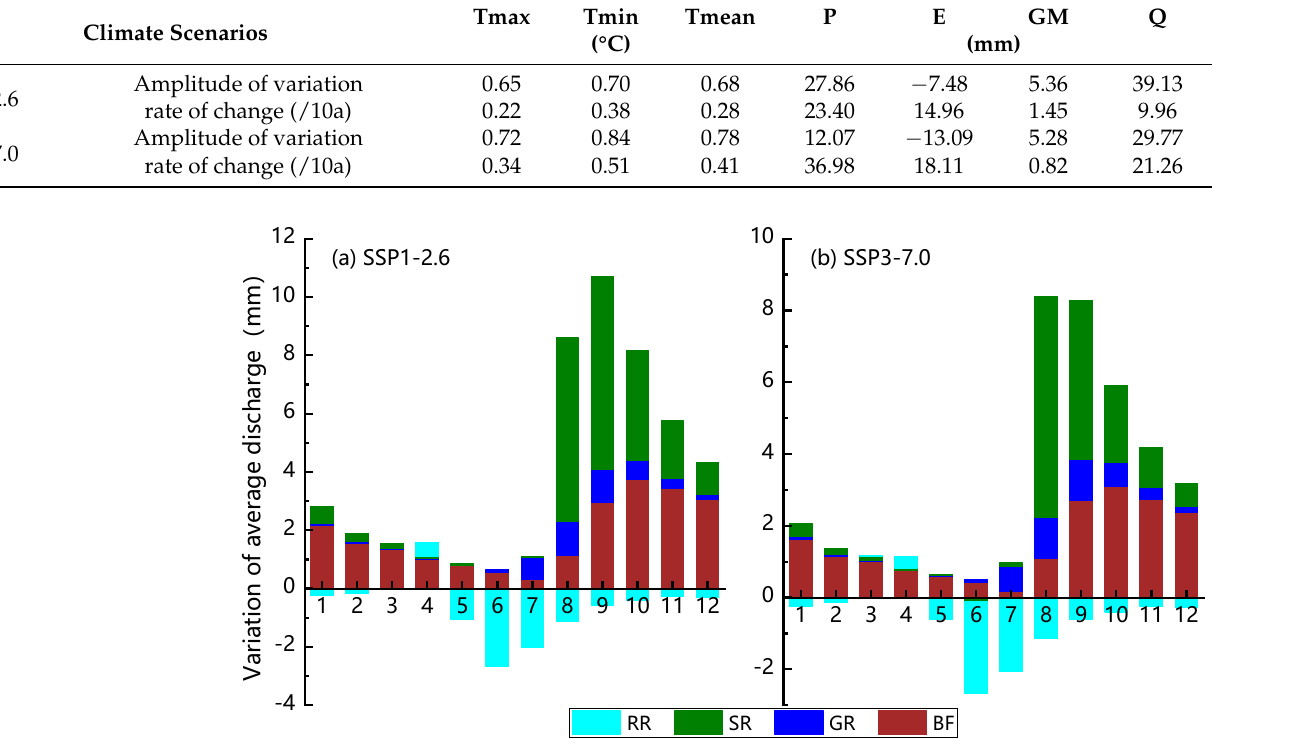
Figure 14. Monthly variations of RR, SR, GR and BF under the ( a ) SSP1-2.6, and ( b ) SSP3-7.0 climate scenarios.